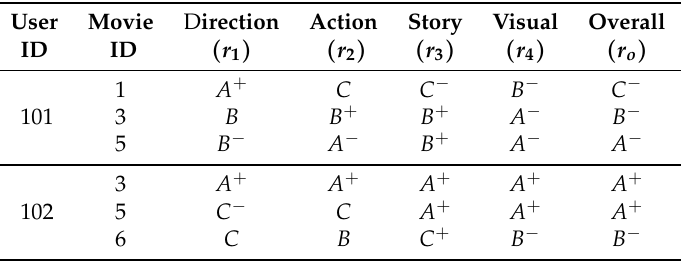
Table 2. Sample of the original dataset.